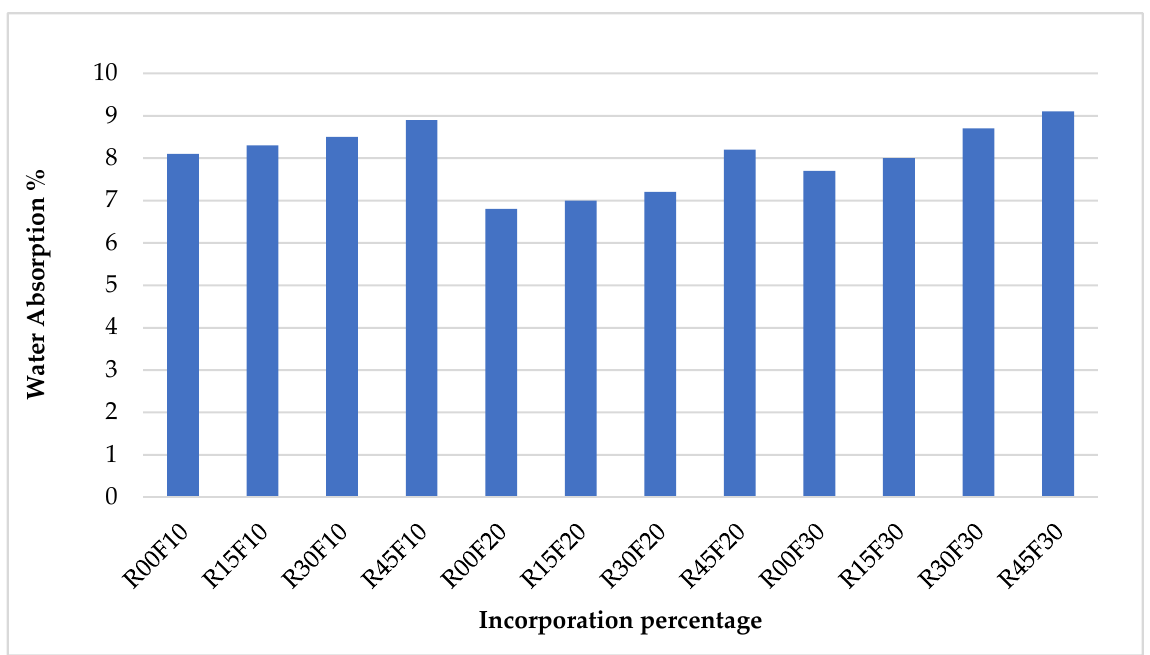
Figure 7. Effect of addition of agro-industrial waste on water absorption (R00F10 refers to 0% rice husk ash and 10% fly ash) [7] .